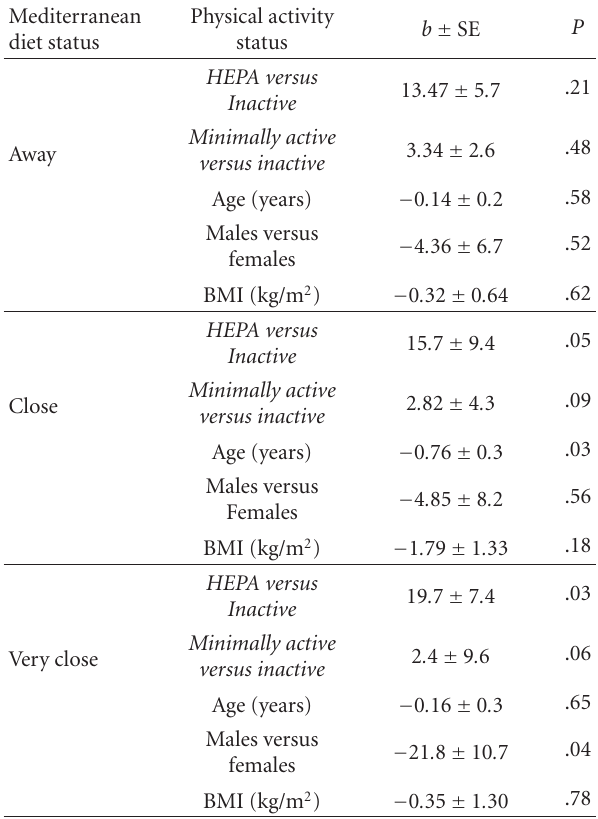
Table 2: Results from multiple linear regression analysis that evaluated the association of physical activity status (independent) on TAC levels (dependent), by dietary